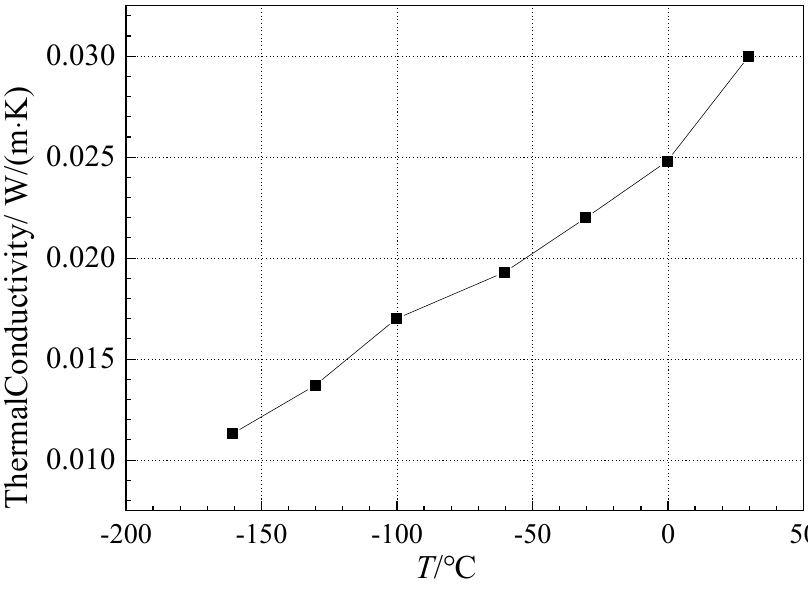
Figure 5. Thermal conductivity of extruded plastic panel samples at − 160 °C~30 °C.